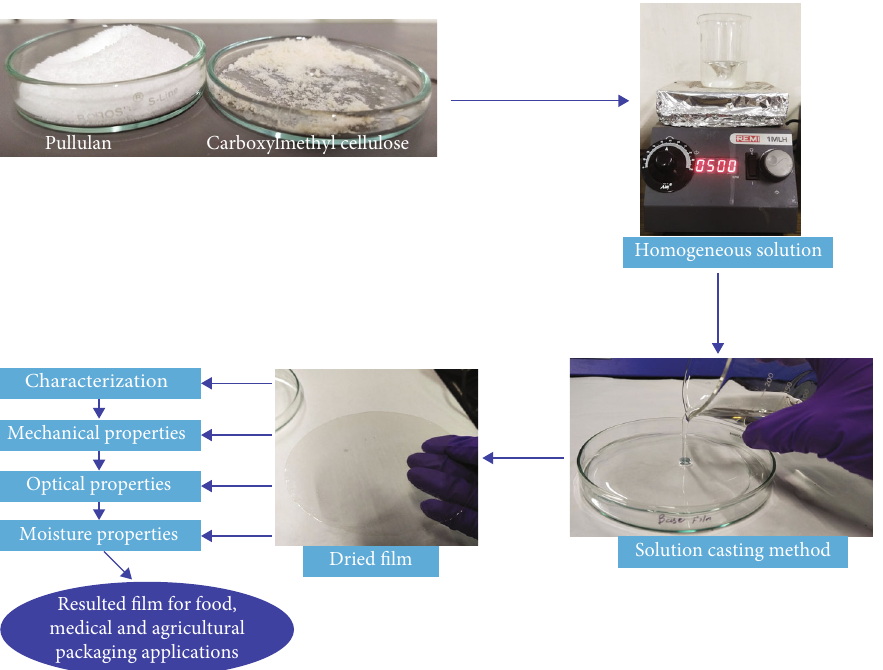
Figure 1: Graphical explanation of edible fi lm fabrication process of